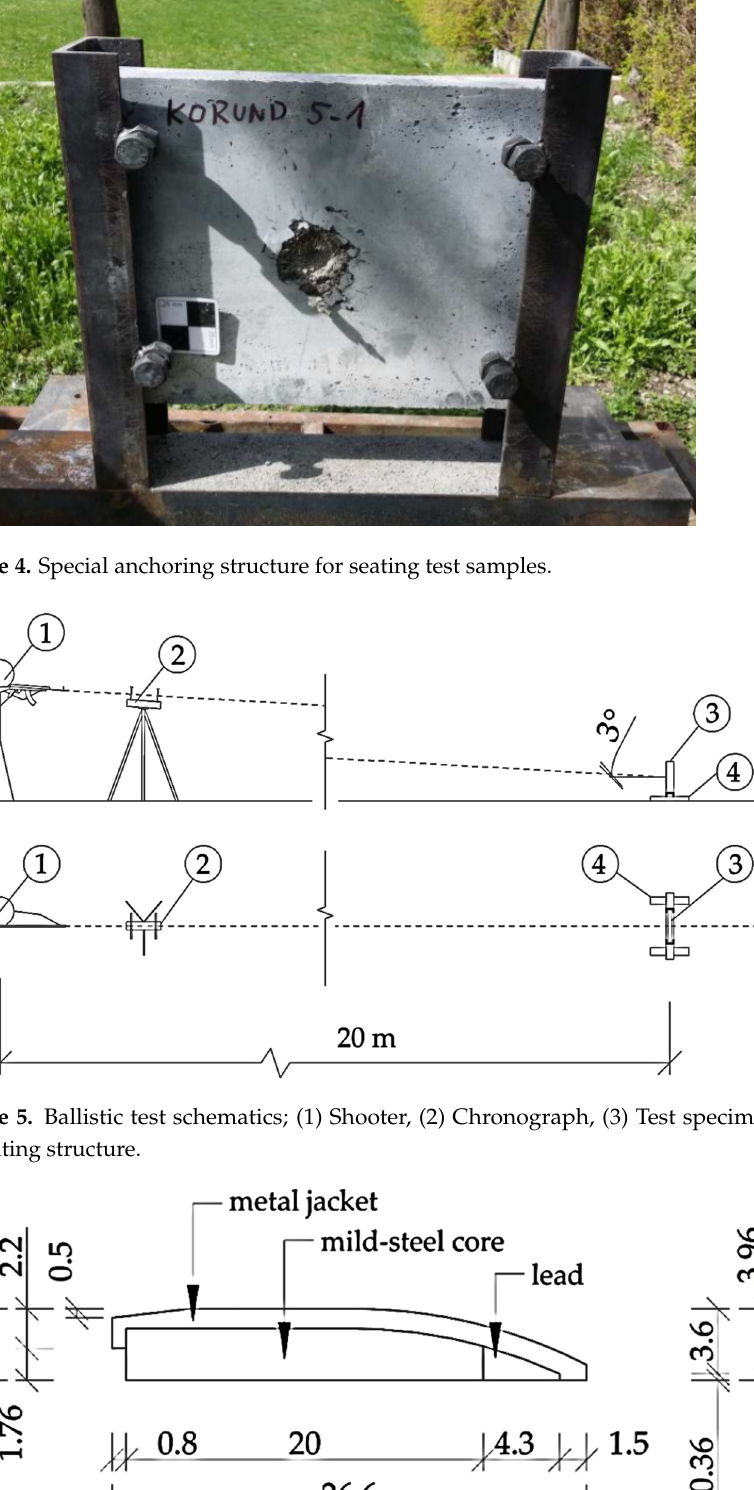
Figure 6. Symmetrical half of the FMJ-MSC projectile, calibre 7.62 × 39 mm. Table 3. Technical parameters and characteristics of the ammunition